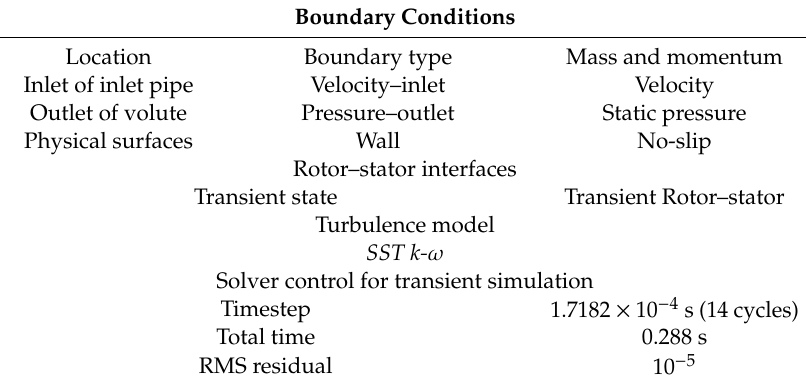
Figure 2. Computational flow domain of the investigated pump. Table 1. Computational setup under single-phase.